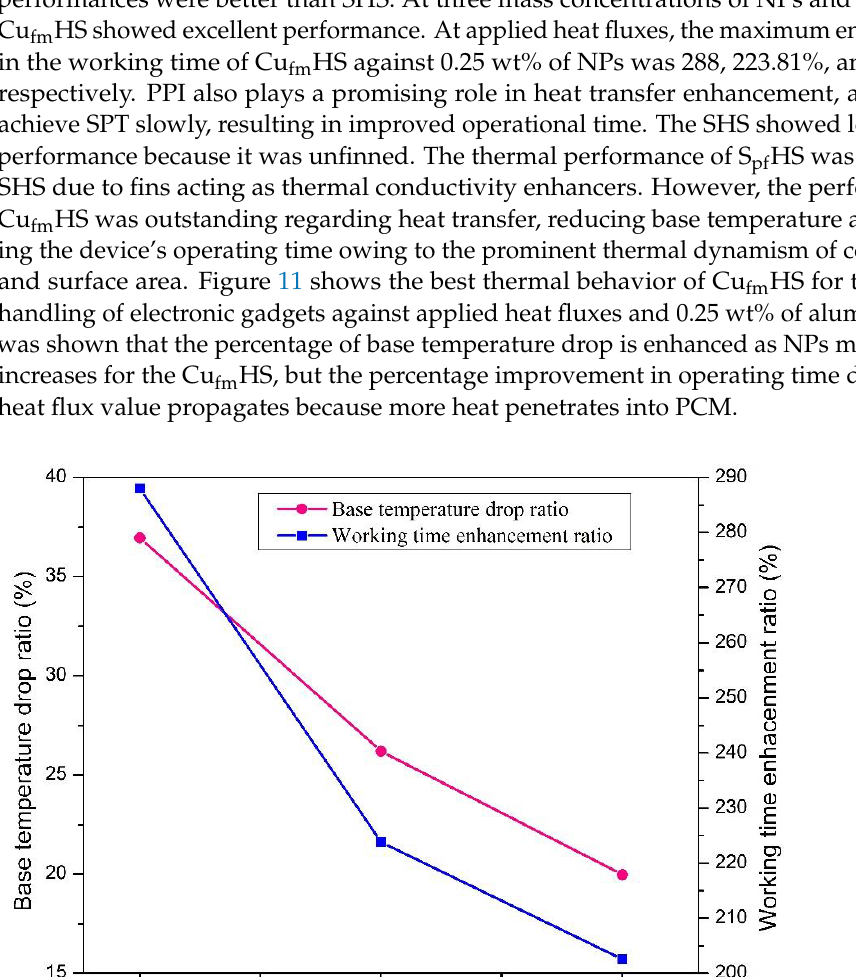
Table 6. Comparison of the T b drop ratio and working time improvement ratio.